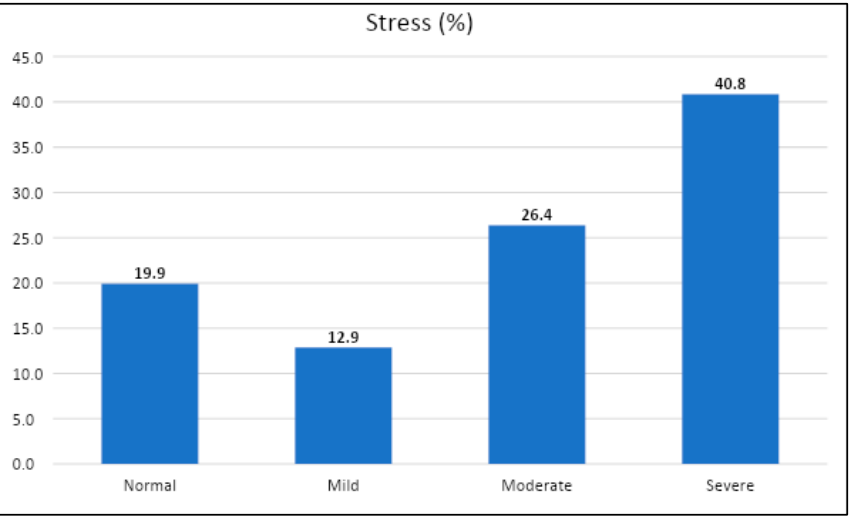
Figure 1. Level of stress using DASS-22 stress scale. Based on the level of agreement, the seven items of the DASS-21 stress scale showed that almost half, 236 (47.5%), agreed they found it difficult to wind down, while 144 (29%) tended to over-react to situations, 176 (35.4%) agreed that they were using a lot of nervous energy, about 167 (33.6%) found themselves becoming agitated, 160 (32.2%) found it difficult to relax, 138 (27.8%) were intolerant of anything that kept them from getting on with what were they doing, and, finally, 164 (33%) found themselves rather touchy (Table 2). Table 2. The seven items of the DASS-21 stress scale reported by responders with COVID-19 infec- tion. The Seven Items of the DASS-21 Stress Scale